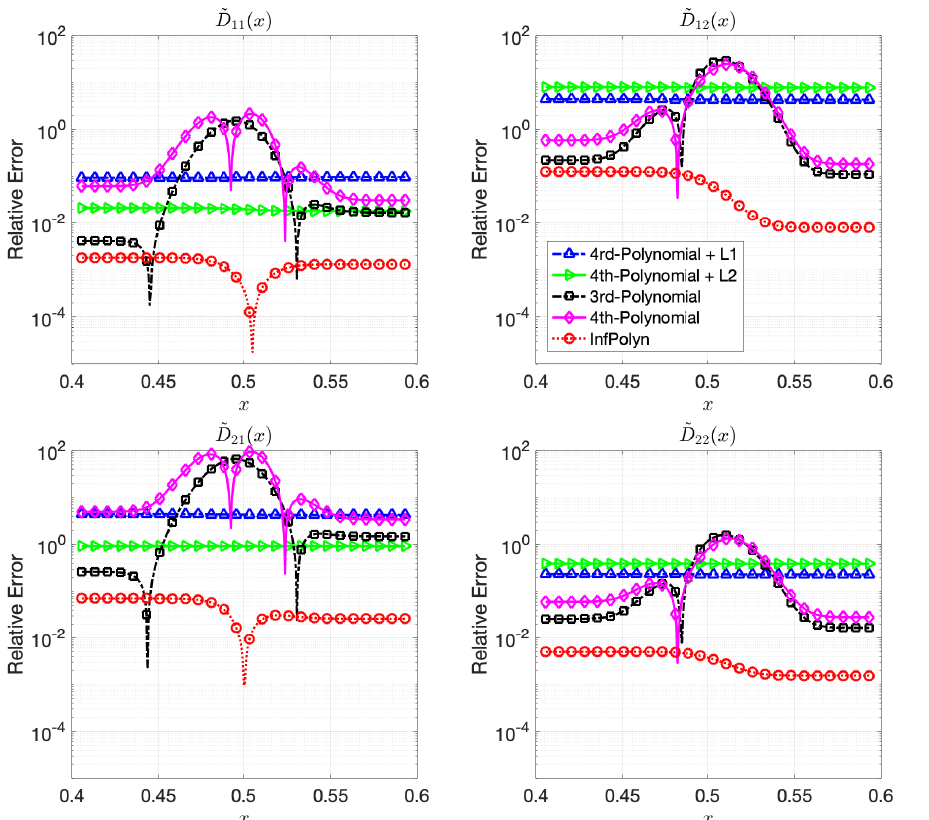
Figure 3. The relative errors (REs) of predictive diffusion coefficients ˜ D ij ( c ( x )) in the center areas x ∈ [ 0.4,0.6 ] for the evaluated methods in a ternary